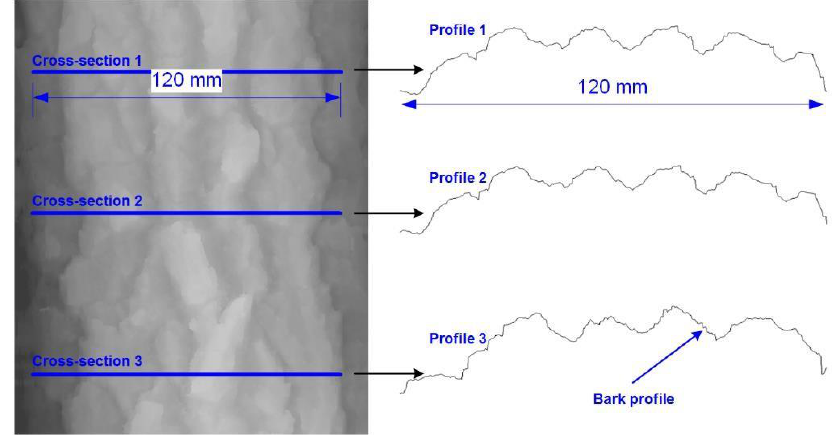
Figure 6. The second step in the analysis of the oak bark surface. ( a ) Firstly, there is a definition of cross-sections. ( b ) Then, a height profile was determined for each cross-section.